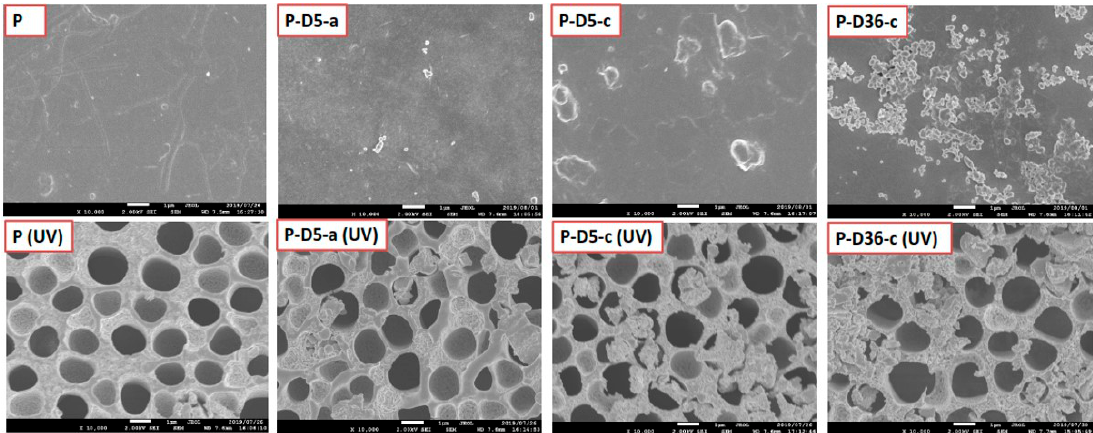
Figure 7. Morphological change of original and modified PES membranes before ( top row ) and after ( bottom row ) seven days of UV